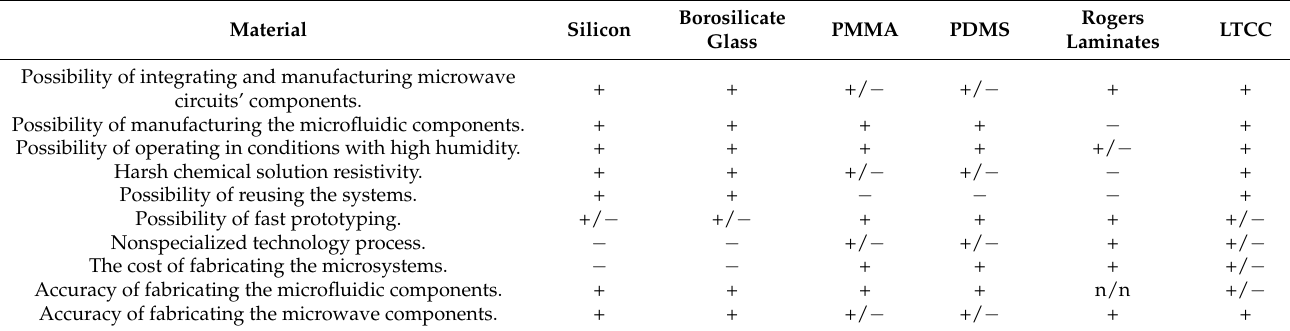
Table 2. The comparison between the silicon, borosilicate glass, polymethyl methacrylate (PMMA), PDMS, Rogers glass- epoxy laminates and LTCC. “+” represents good properties, “+/ − ” represents average or ambiguous properties, and “ − ” represents the weak ones. Borosilicate Rogers Material Silicon PMMA PDMS LTCC Glass Laminates Possibility of integrating and manufacturing microwave + + +/ − +/ − + + circuits’ components. Possibility of manufacturing the microfluidic components. + + + +